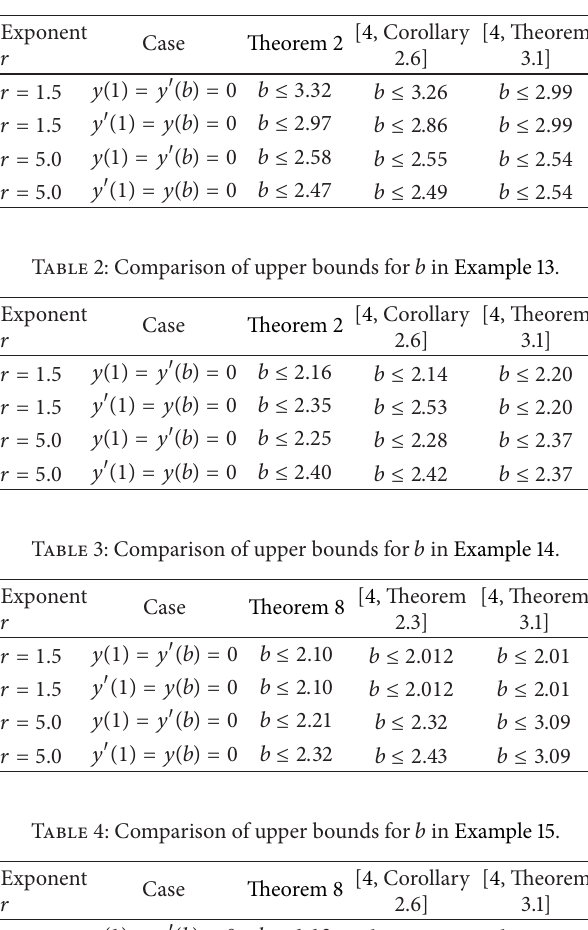
Table 1: Comparison of upper bounds for 𝑏 in Example 12.